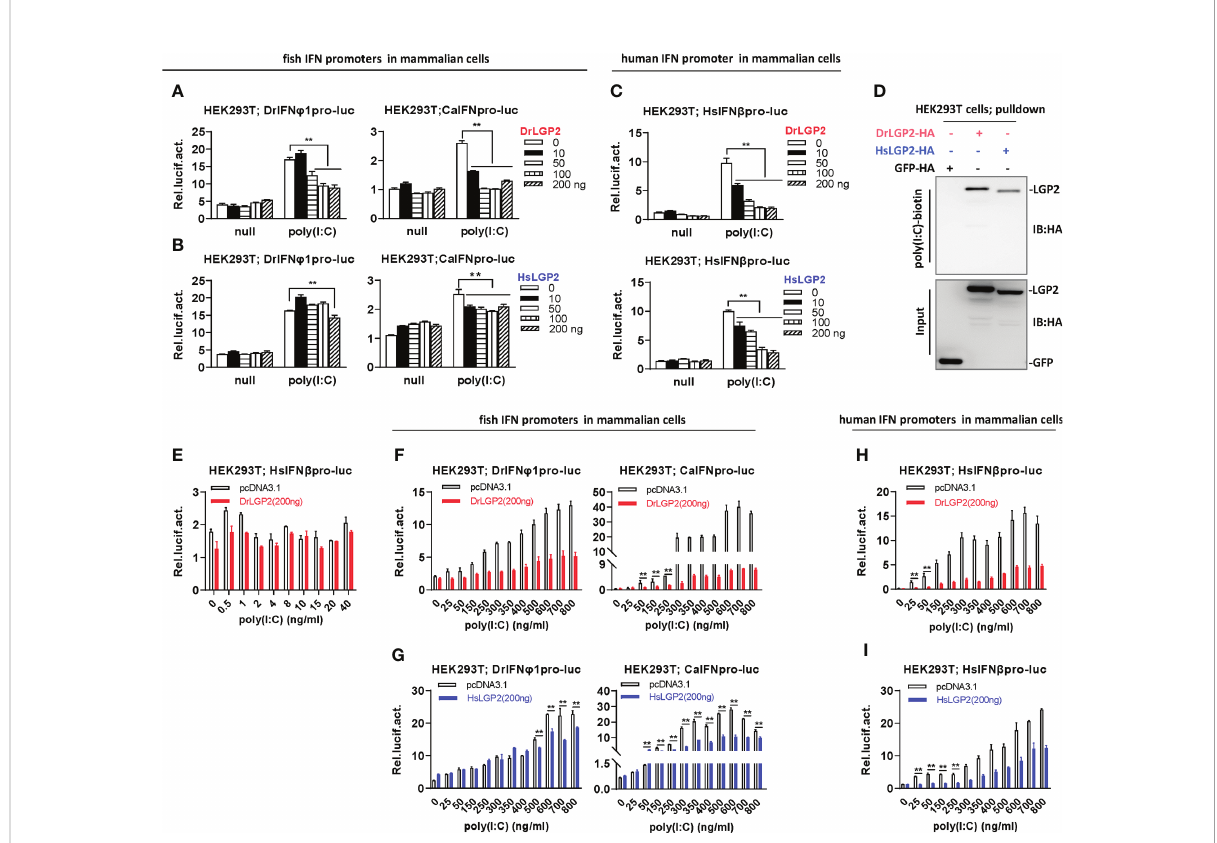
FIGURE 4 Zebra fi sh and human LGP2s play a negative role in regulating IFN response by high concentrations of poly(I:C) in mammalian cells (A – C) DrLGP2 and HsLGP2 downregulated fi sh IFN and human IFN b promoter activation by poly(I:C) at a high concentration of 2 m g/ml in mammalian cells. HEK293T cells seeded in 24-wells plates were co-transfected with DrIFN j 1pro-luc or CaIFNpro-luc (A, B) , or HsIFN b pro-luc (200 ng each) (C) , together with DrLGP2 or HsLGP2 at increasing doses (0, 10, 50, 100, 200 ng). 24 h later, cells were transfected with 2 m g/ml poly(I:C) for another 24 h, followed by luciferase assays. P values were calculated using ANOVA. ** P < 0.01. (D) RNA pull-down assays veri fi ed the binding of poly(I:C) to DrLGP2 and HsLGP2 in mammalian cells. HEK293T cells seeded in 10 cm dishes were transfected with DrLGP2-HA, HsLGP2-HA or GFP-HA as control. 24 h later, cells were lysed. One-tenth of cell lysates were taken as input, the remaining was incubated with 100 ng biotinylated poly(I:C), followed by western blots with anti-HA antibody. (E – I) Titration of poly(I:C) revealed a negative regulation of zebra fi sh and human LGP2s on IFN response in mammalian cells. HEK293T cells seeded in 24-wells plates were co-transfected with HsIFN b pro-luc (E, H, I) , or with DrIFN j 1pro-luc or CaIFNpro-luc (F, G) , together with DrLGP2 (E, F, H) or HsLGP2 (G, I) (200 ng each). Renilla vector (pRL-TK, 0.2 ng) was transfected as internal control. 24 h later, cells were transfected with poly(I:C) at increasing doses for another 24 h, followed by luciferase assays. P values were calculated using Student ’ s t-test. ** P <